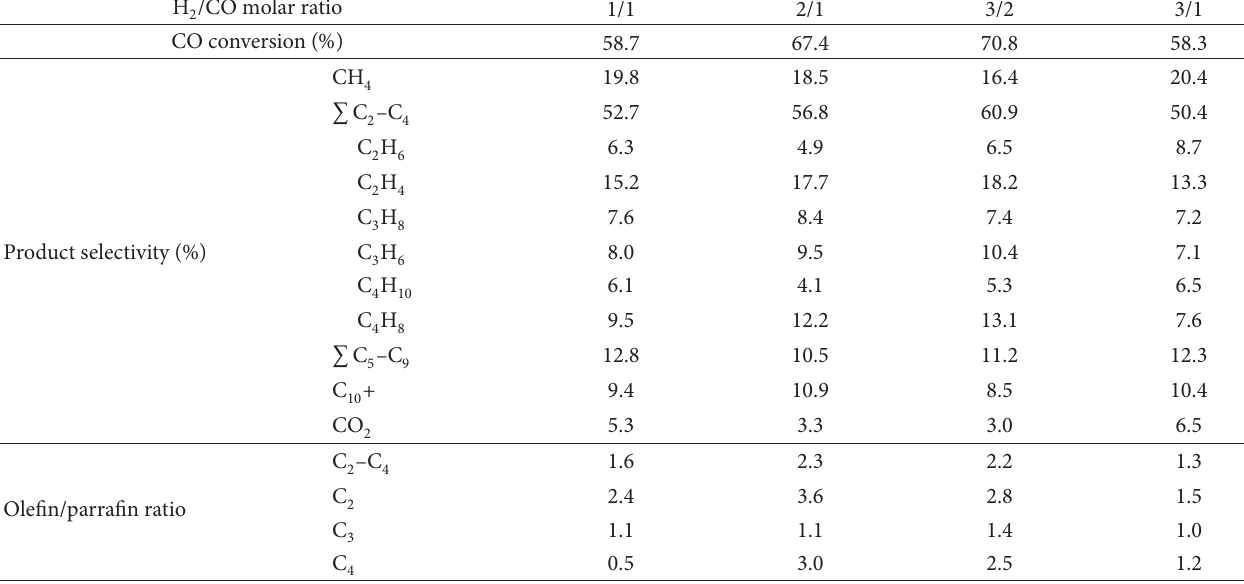
/CO feed ratio on the catalytic performance of catalyst. 2